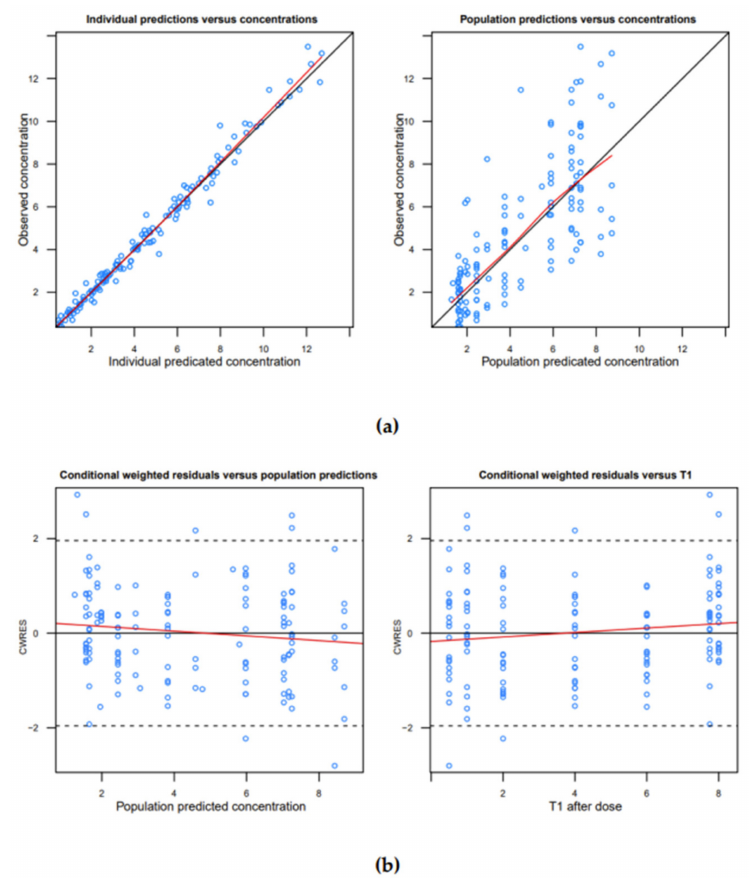
Figure 1. ( a ) Observed versus (left) individual-predicted or population-predicted (right) clindamycin concentrations (mg/L); or ( b ) conditional weighted residuals (CWRES) versus (left) population- predicted concentration or (right) hour post-dose intake (T1 after